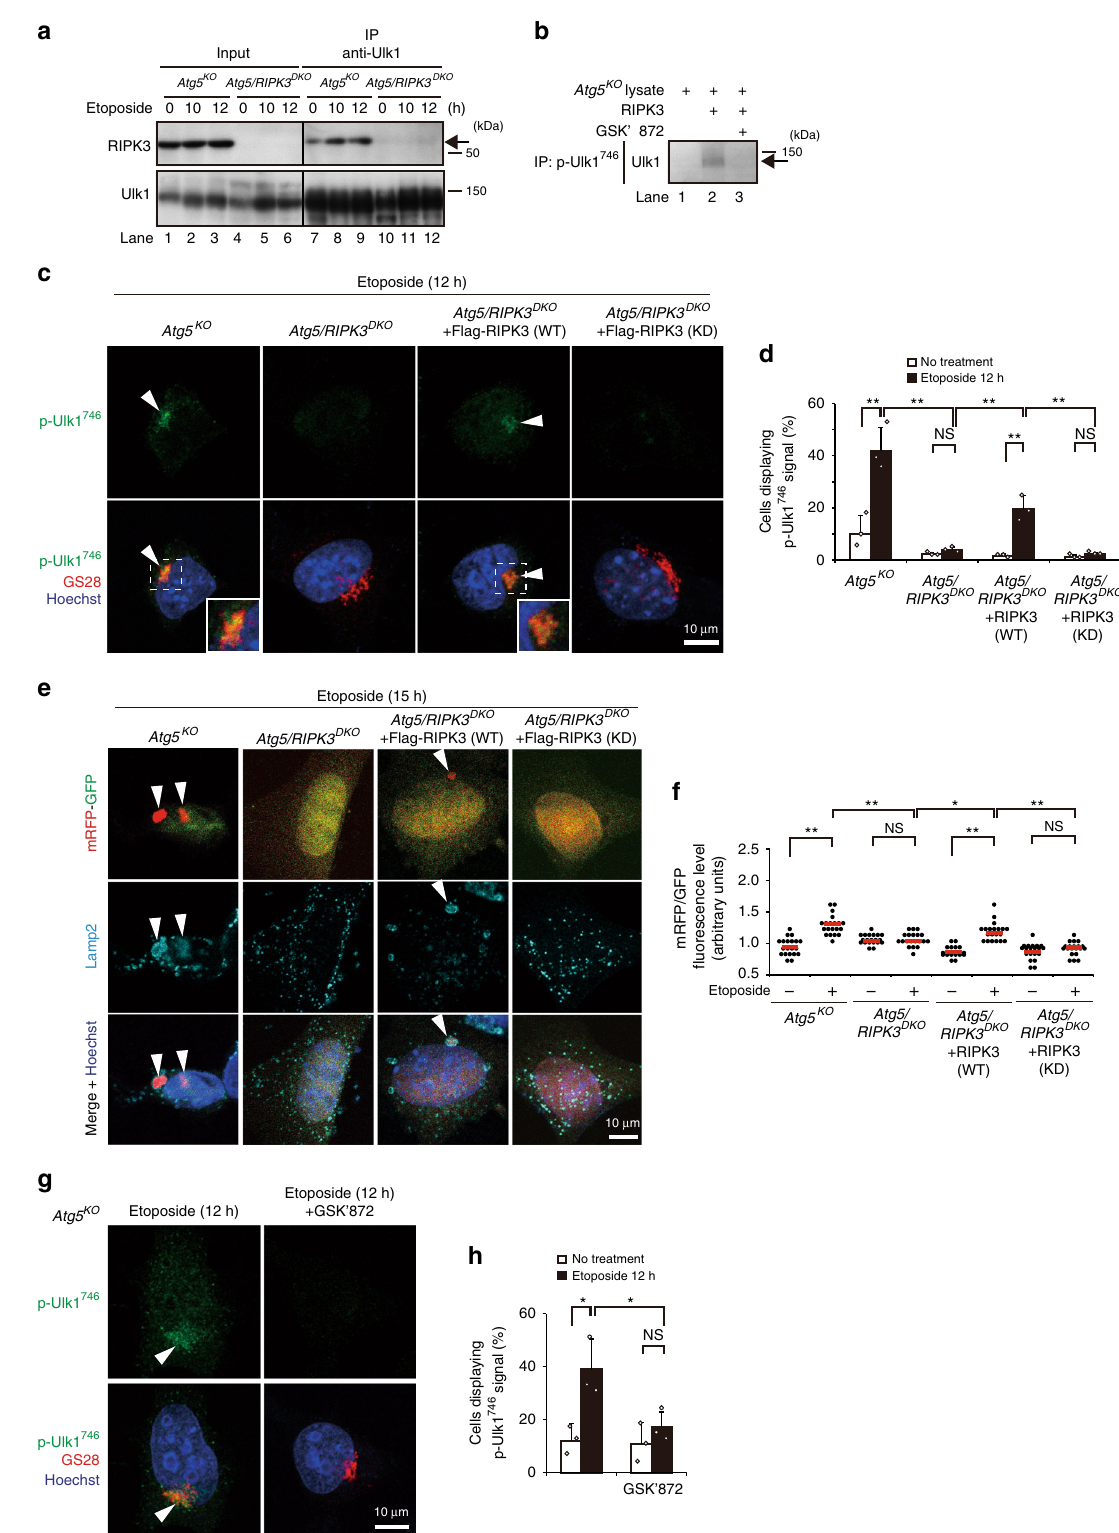
RIPK3 expression was dramatically suppressed in Atg5/p53 double-knockout ( Atg5/p53 DKO ) MEFs (Fig. 8a). Very weak expression of RIPK3 was con fi rmed using different p53 KO MEFs (Supplementary Fig. 21a) and by the analysis of mRNA levels (Fig. 8b). Thus, RIPK3 activation upon genotoxic stress was